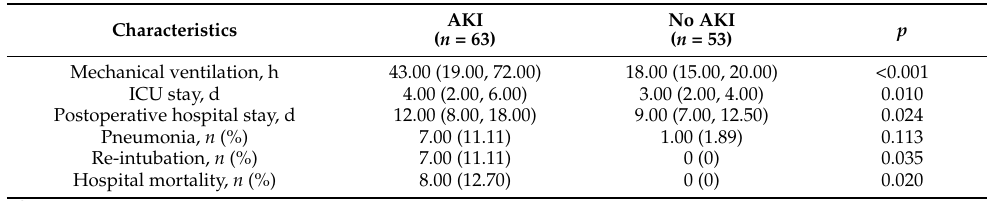
Table 2. Comparison of postoperative outcomes between patients with and without postoperative acute kidney injury. Characteristics